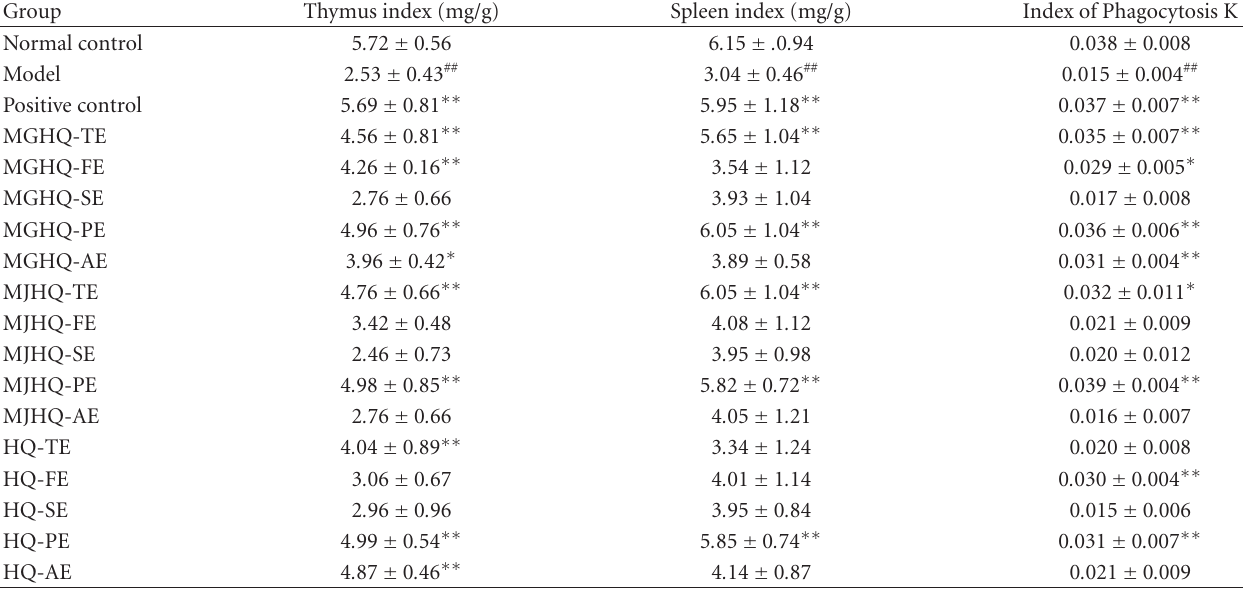
Table 5: E ff ects of di ff erent extracts on mice immune organs and